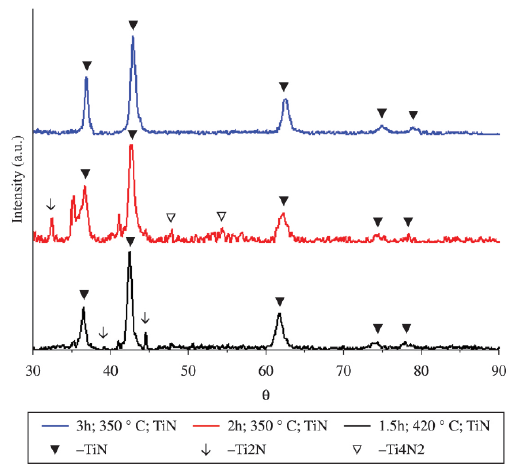
Figure 3. X- Ray diffractogram in rasante incident of deposited glass sample using two Titanium cages in 350 and 420ºC and 1.5, 2 and 3 treatment time.